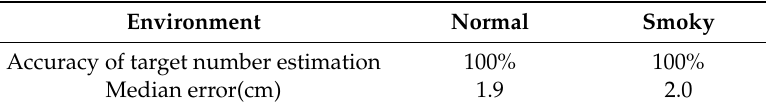
Figure 14. Smoky environment. Table 4. The results in smoky environment.